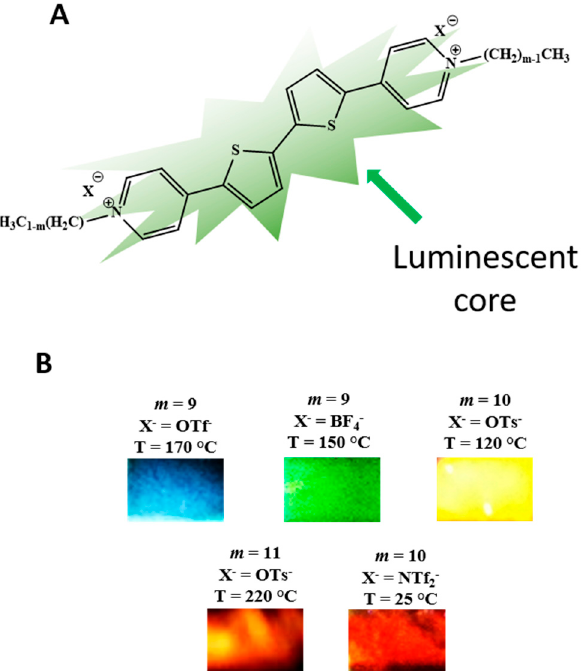
Figure 1. ( A ) Structures of the thienoviologens salts mVX forming ionic liquid crystals, with m indicating the promesogenic alkyl chains attached to the π -extended luminescent thienopyridinium core (V) and X - the anion. ( B ) Photographs of the light emitted (excitation at 430 nm) by thin films formed between two glass substrates by some thienoviologen salts in the LC state, showing the full color palette obtainable as a function of X - , m and the temperature (T).